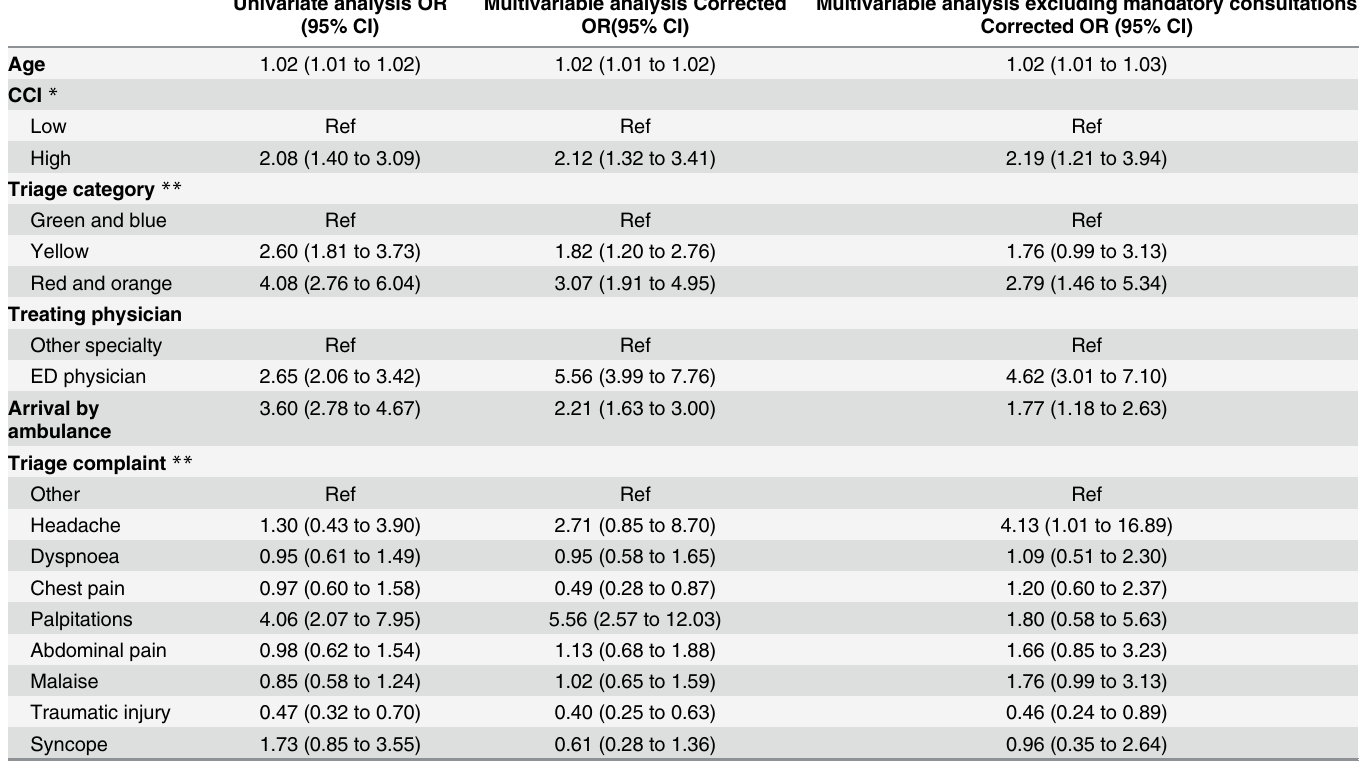
Table 4. Multivariable logistic regression analysis to predict